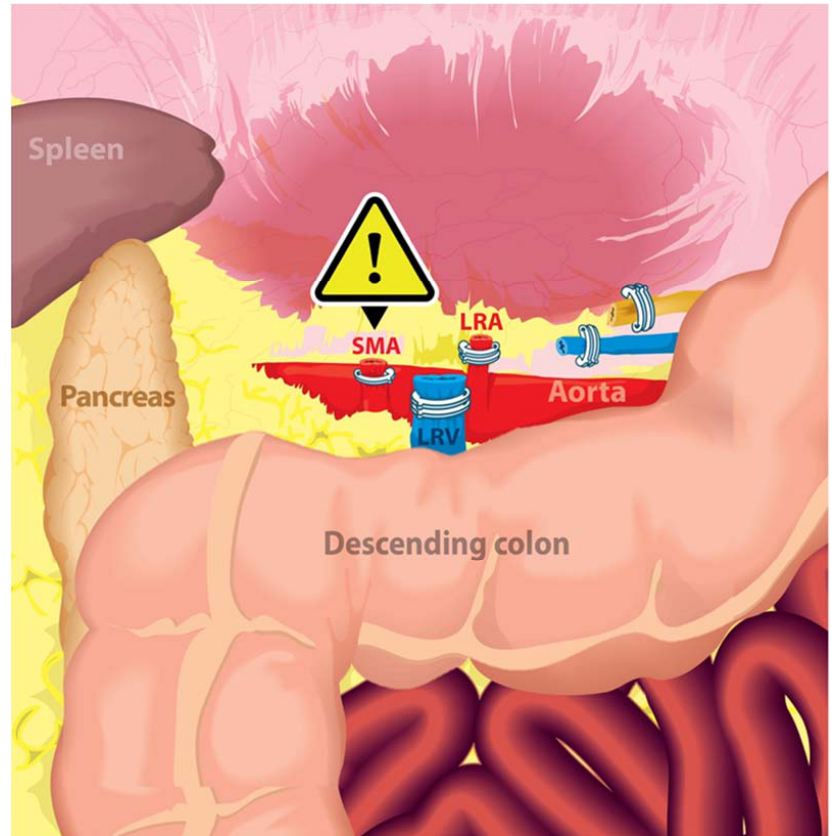
Figure 7 . Bowel ischemia following SMA injury during robotic radical nephrectomy. SMA: superior mesenteric artery; LRA: left renal artery; LRV: left renal vein.